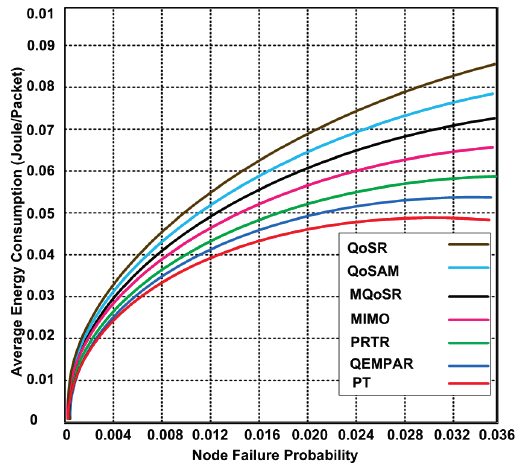
Figure 7. Average energy consumption vs. node failure